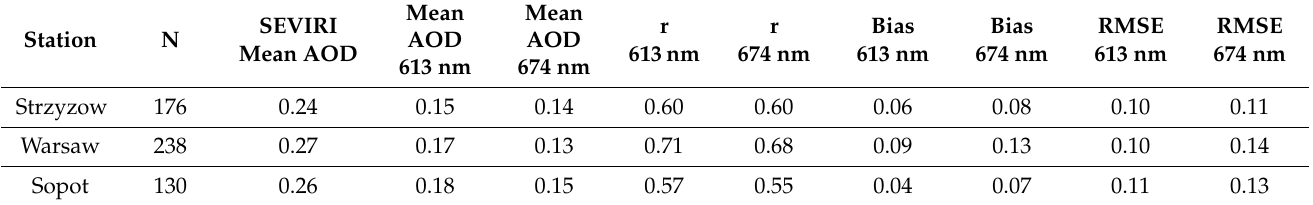
Table 3. Summary statistics: SEVIRI AOD vs. a geostationary Poland–AOD.